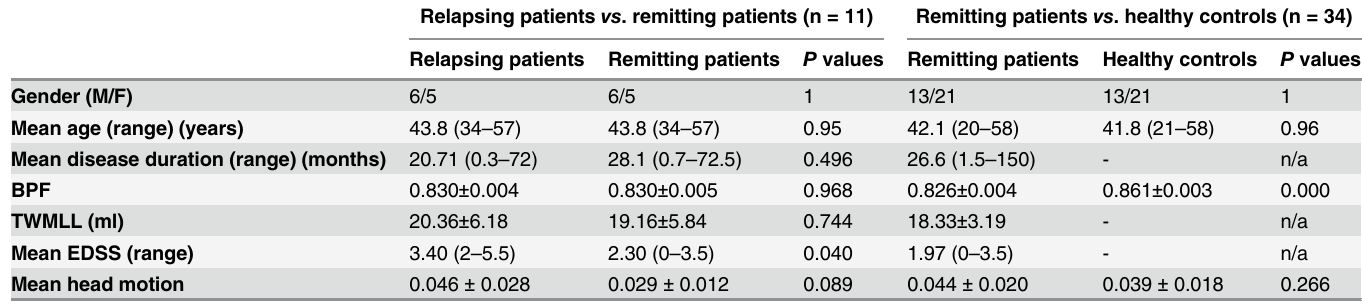
Table 1. The demographic and clinical characteristics of the study population. Relapsing patients vs . remitting patients (n =